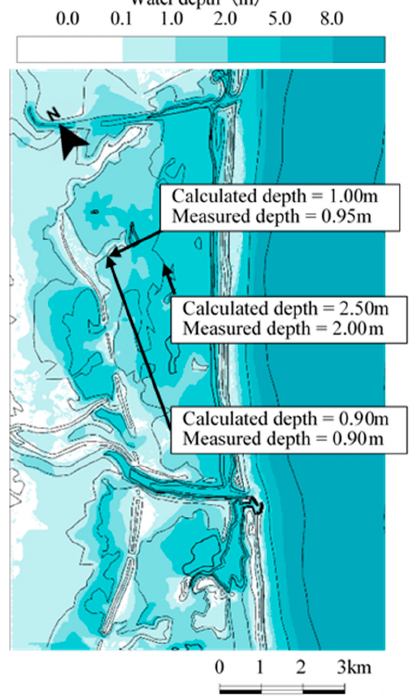
Figure 34. Flood situation in Sendai Coast 48 min after arrival of the 2011 huge